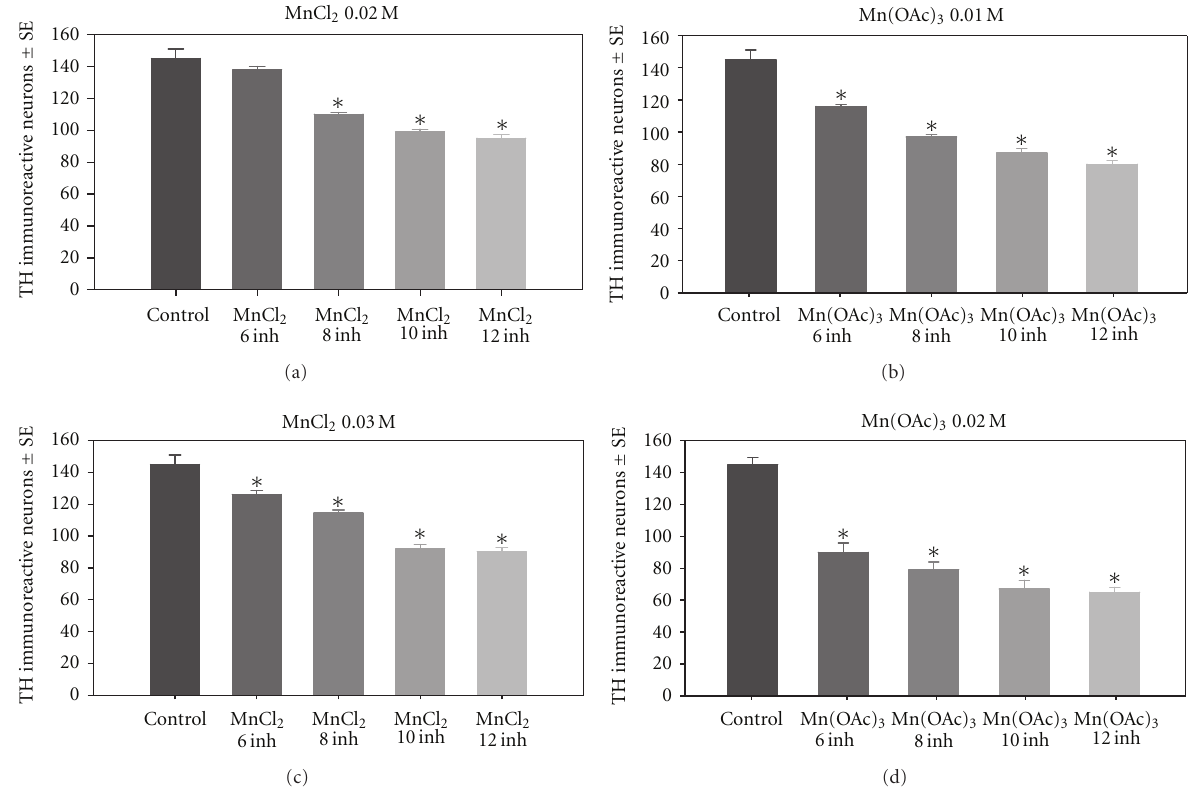
Figure 6: Pilot study. Number of SNc TH + -immunostained neurons from control and exposed mice after di ff erent times of 0.02M MnCl 2 (a) and 0.03M MnCl 2 (c) inhalations and after di ff erent times of 0.01M Mn(OAc) 3 (b) and 0.02M Mn(OAc) 3 (d) inhalations. The data are presented as the mean ± standard error (SE) ( ∗ P < . 05 one-way ANOVA).